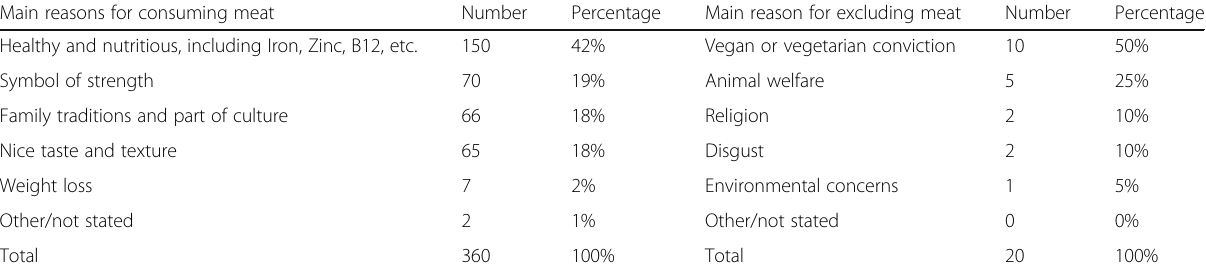
Table 3 Main reason for the dietary choice related to meat consumption, Sydney, 2018 Main reasons for consuming meat Healthy and nutritious, including Iron, Zinc, B12, etc.